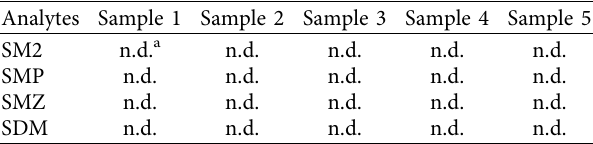
Table 4: The analytical results of four SAs in real water samples.